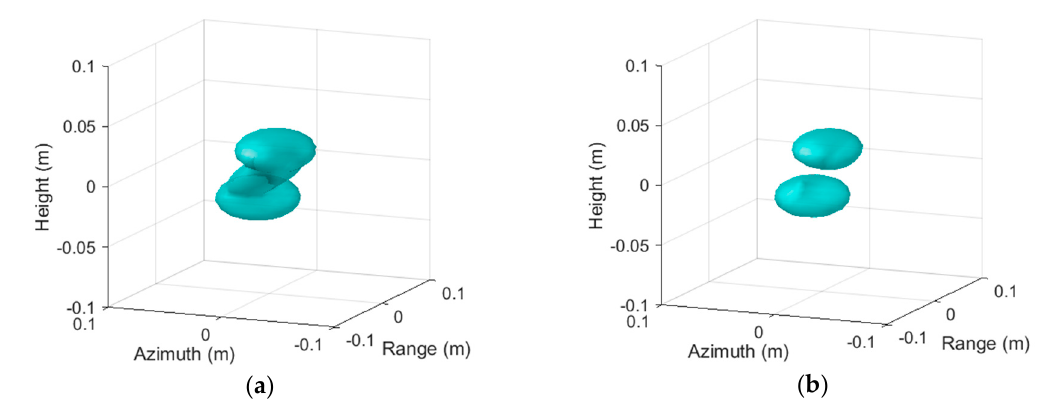
Figure 12. Final 3-D imaging result of two adjacent trihedral. ( a ) Equal-interval; ( b ) non-uniform.